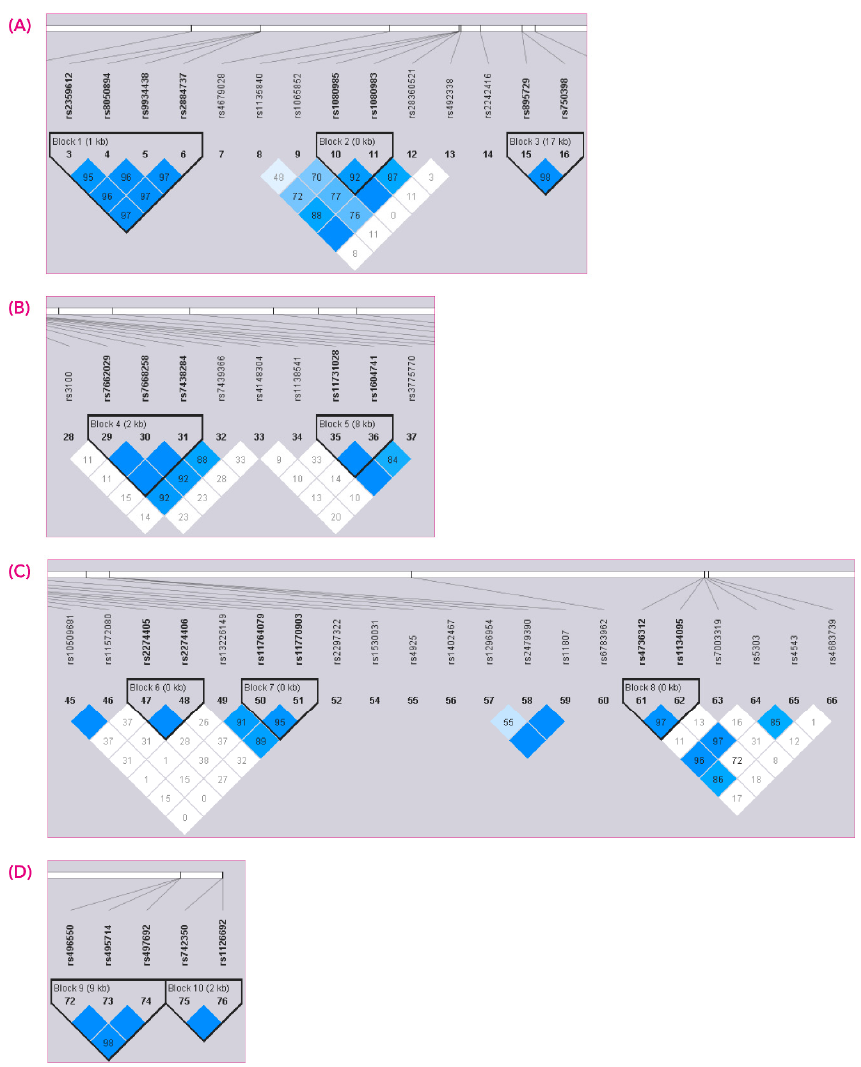
Figure 3. Haploview linkage disequilibrium graph. A total of 10 haplotype blocks were identified ( A – D ). Block 9 ( D ) was the only one statistically associated with the achievement of MMR with